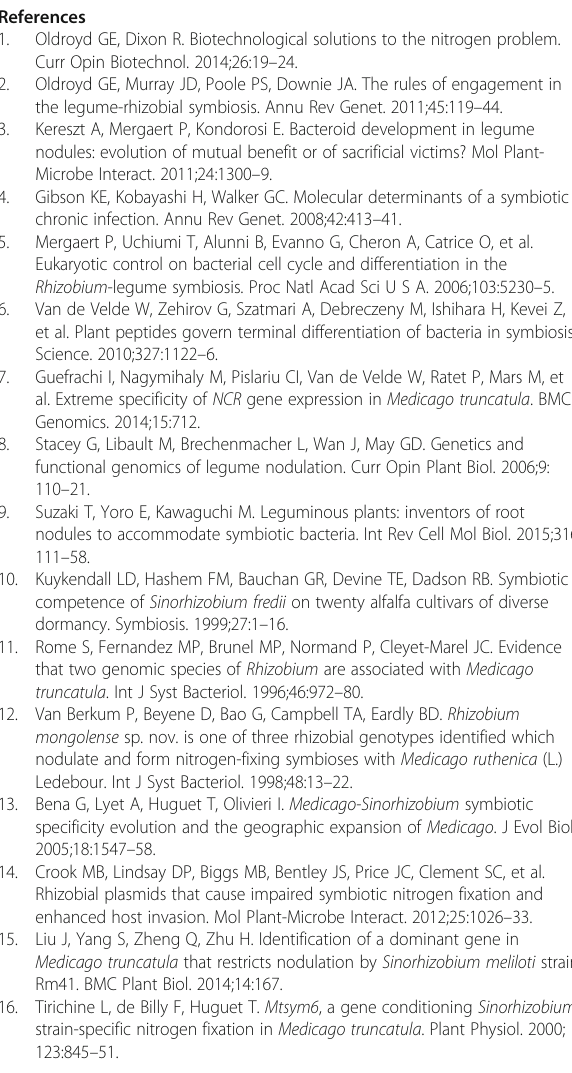
Additional file 1: Figure S1. Multilocus Sequence Analysis of 14 genes, recA , gltA , glnA , ctrA , ftsA , ftsZ1 , ftsZ2 , gyrB , dnaK , pnp , rpoB , thrC , atpD and gap in E. meliloti strains FSM-MA, Sm1021, Su47, Rm41, AK58, AK83, SM11, GR4, BO21CC and BL225C, E. arboris strain LMG14919, E. medicae strain WSM419 and E. fredii strains USDA257, NGR234 and HH103. The concatenated gene sequences (total 23,220 bp) were aligned by ClustalW and a maximum likelihood tree was inferred from the aligned sequences using MEGA ver. 6.0.6 software (Tamura et al., 2007). The tree was estimated using the Tamura-Nei substitution model (Tamura and Nei, 1993). Bootstrap tests were performed with 1000 replications. The inset shows the topology of the maximum likeli-